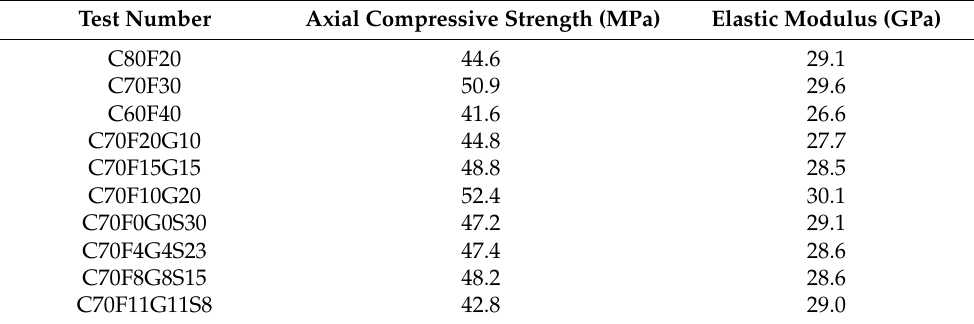
Table 8. Axial compressive strength and elastic modulus of